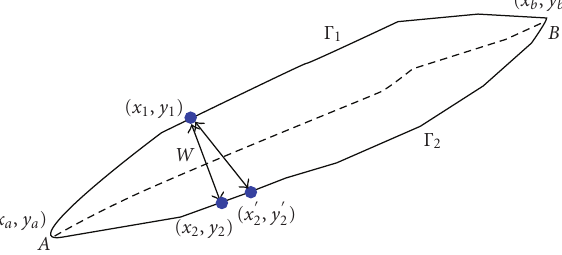
Figure 5: Definition of crack width: the distance from ( x 1 , y 1 ) to ( x 2 , y 2 ) is the shortest compared with others, for example, from ( x 1 , y 1 ) to ( x (cid:12) 2 , y (cid:12) 2 ); the former defines the crack width w at ( x 1 , y 1